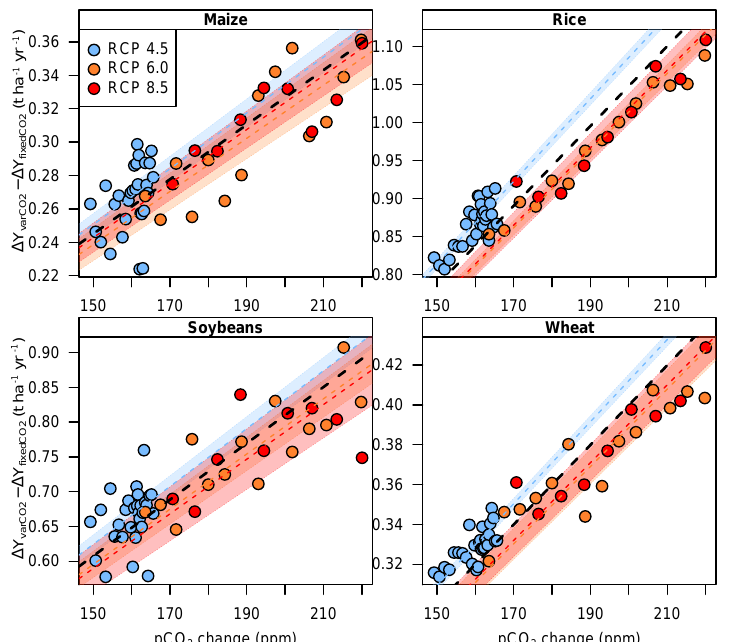
Figure 5. Difference in global mean yield change (sum of rain-fed and irrigated, and weighted by year-2000 growing areas) between the default ( Y varCO ) and fixed-CO 2 simulations ( Y fixedCO ), for each crop over the range of p CO 2 associated with the (cid:49) GMT = 2.5 ◦ C bin. 2 2 Results are as simulated by LPJmL forced with output from HadGEM2-ES. Each colour represents an emissions scenario. Points mark individual years while dotted lines and shaded areas indicate the linear best fit and its 95% confidence interval for each scenario. The black dotted line indicates the linear best fit through all available scenarios. Analogous figures for other GGCMs and warming bins are available in the